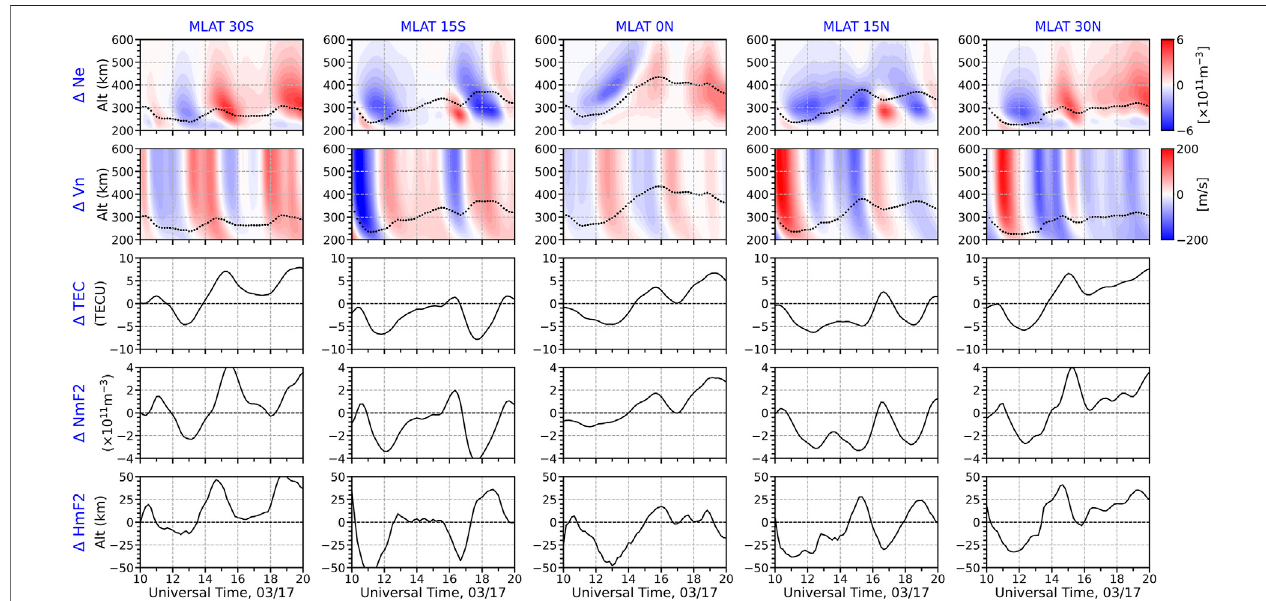
FIGURE 5 | (From top to bottom) Storm-quiet differences of the electron density, meridional wind, TEC, NmF2 and HmF2 at fi ve locations at 70 ° W calculated from the GITM outputs. The electron density and meridional wind are plotted as a function of UT and altitude while other parameters are shown as a function of UT. For the meridional wind, positive values indicate northward winds (poleward in the NH and equatorward in the SH). NH, northern hemisphere; SH, southern